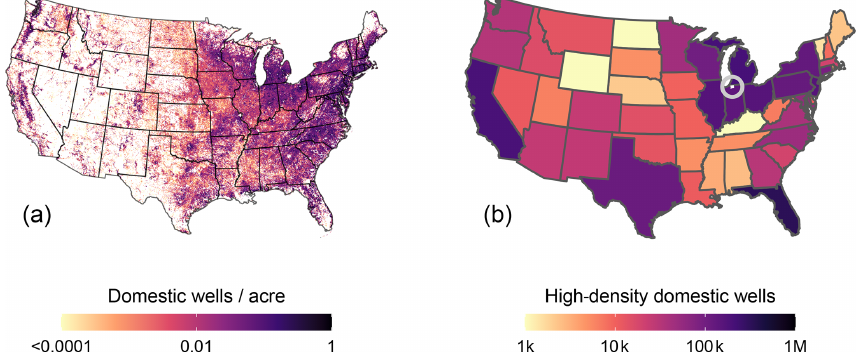
Figure 1. Concentration of households with domestic wells in the contiguous United States. (a) Gridded (1km) density of wells. (b) Total number of high-density wells by state, defined as wells (in 1km pixels) where the average density is at least one per acre. Data are from Johnson et al. (2019). The location of the case study (Sect. 4) is marked inside the gray